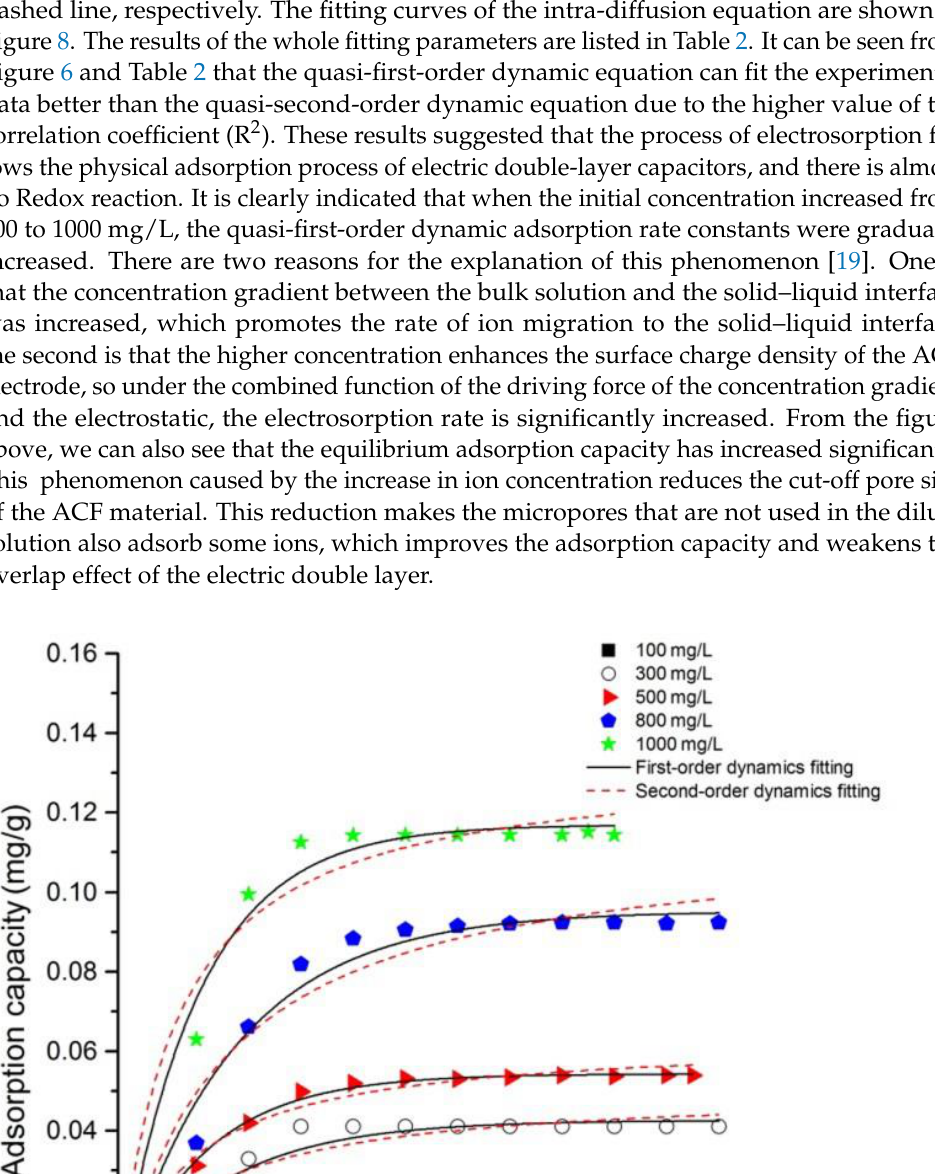
Figure 8. The curve of the electrosorption capacity with time to the power of 0.5 under different concentrations. Table 2. Dynamic equation fitting results. Concentration (mg/L)